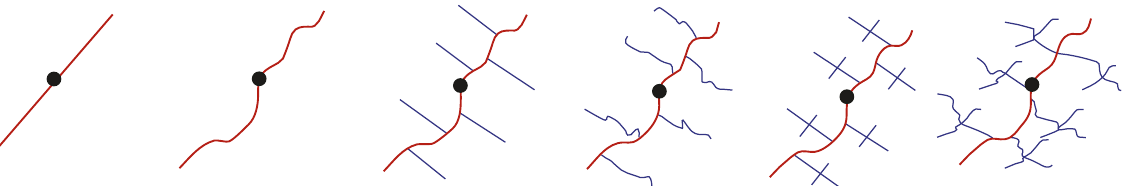
Figure 11: Some examples of different complex planar/nonplanar hydraulic fracture networks